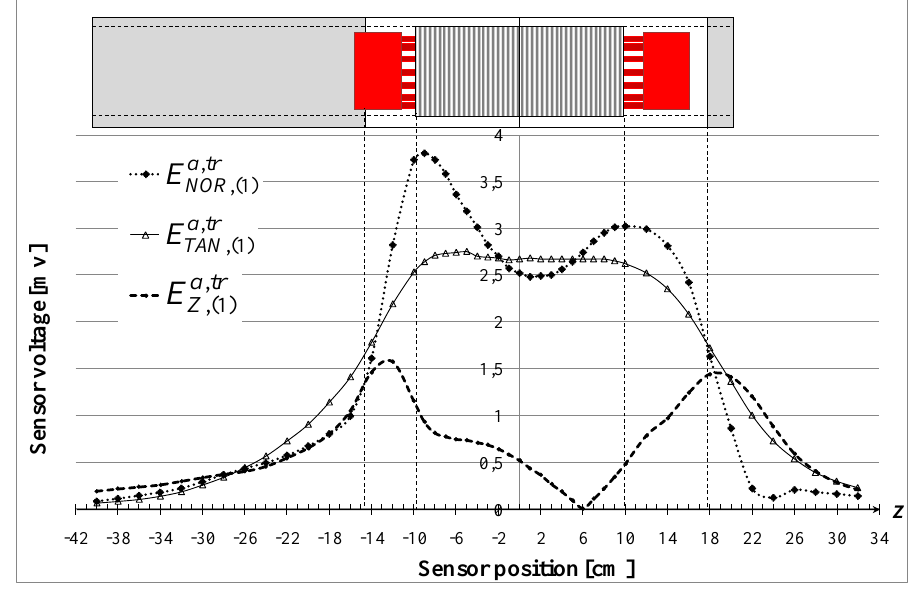
Figure 12. Variations of the normal, tangential and axial fundamental components tra tra and E , TAN )1(,